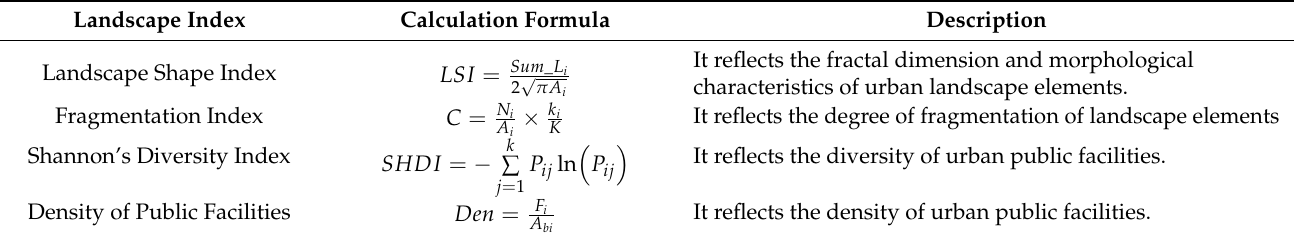
Table 3. Landscape index